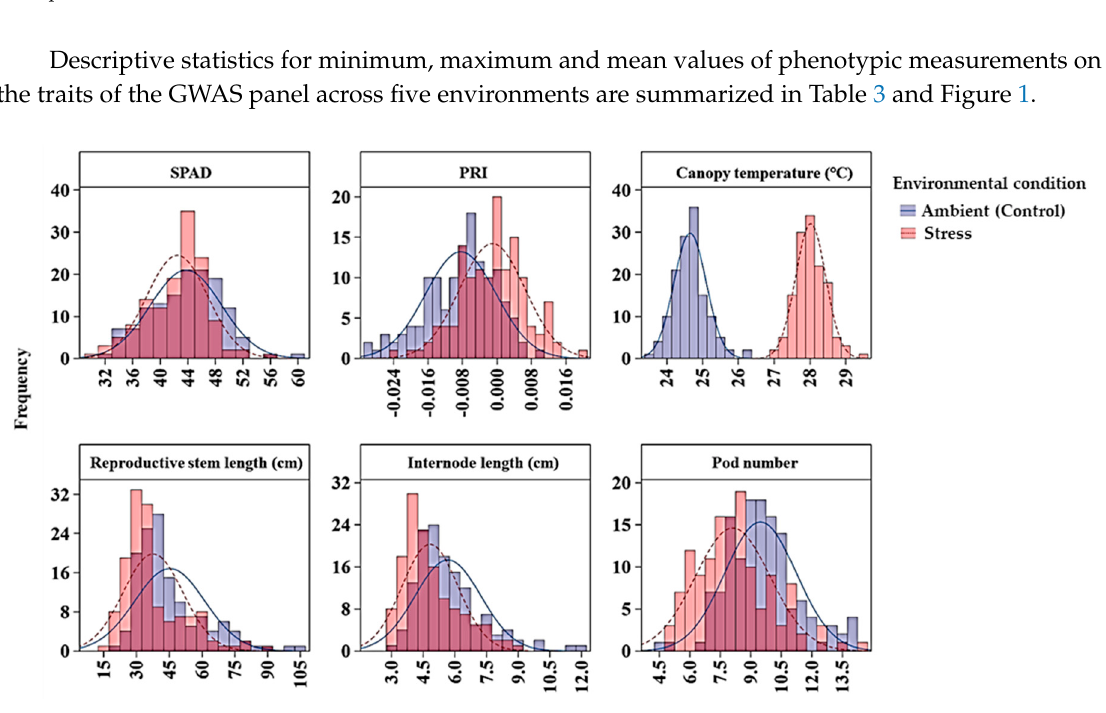
Figure 1. Distribution of average SPAD, PRI, canopy temperature, reproductive stem length, internode length and pod number of 135 GWAS accessions across ambient and stress environments. Note: The ambient (control) environments were 2016 Rosthern, 2016 Saskatoon and 2017 Rosthern; and the heat stress environments were 2015 and 2017 Saskatoon. PRI, photochemical reflectance